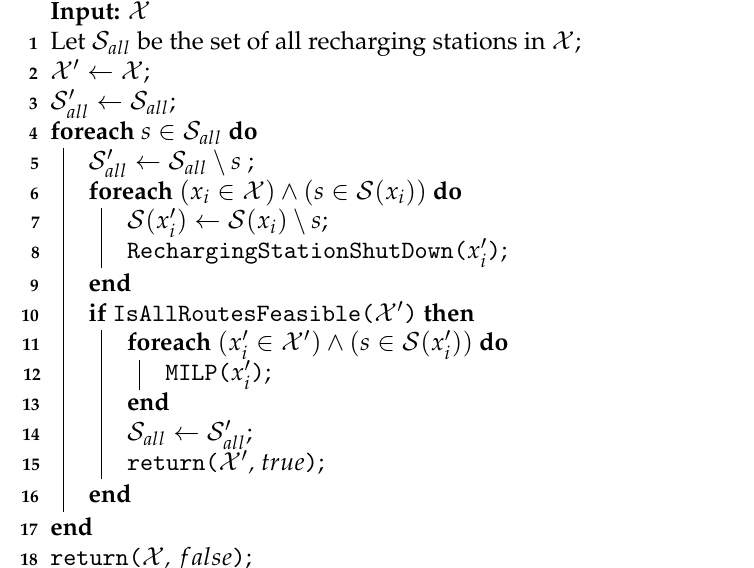
Algorithm 11: Recharging Station Shutdown performed on